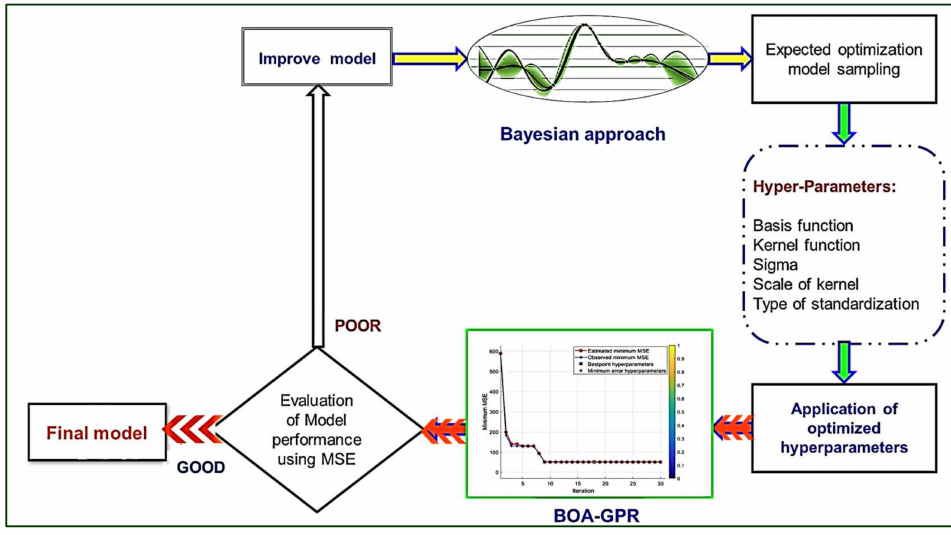
Figure 3. BOA-GPR flow